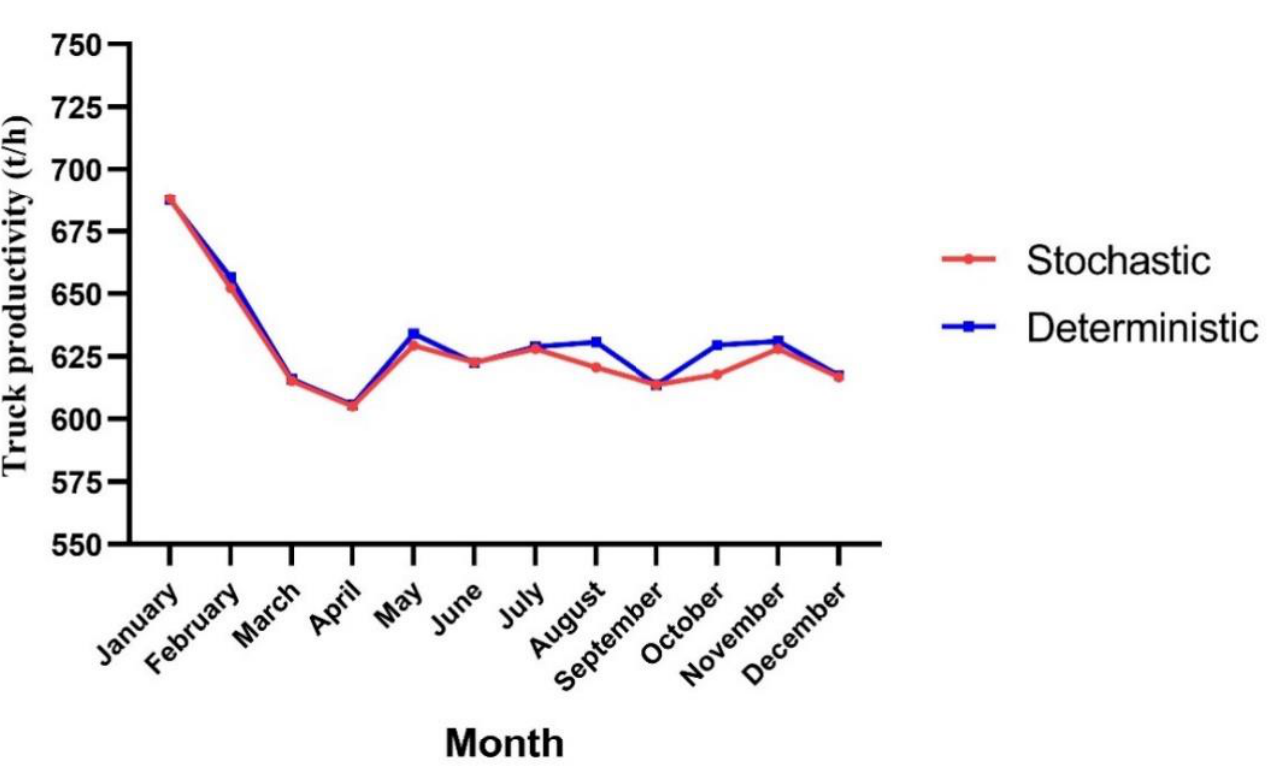
Figure 11. Truck productivity in the stochastic and deterministic models.